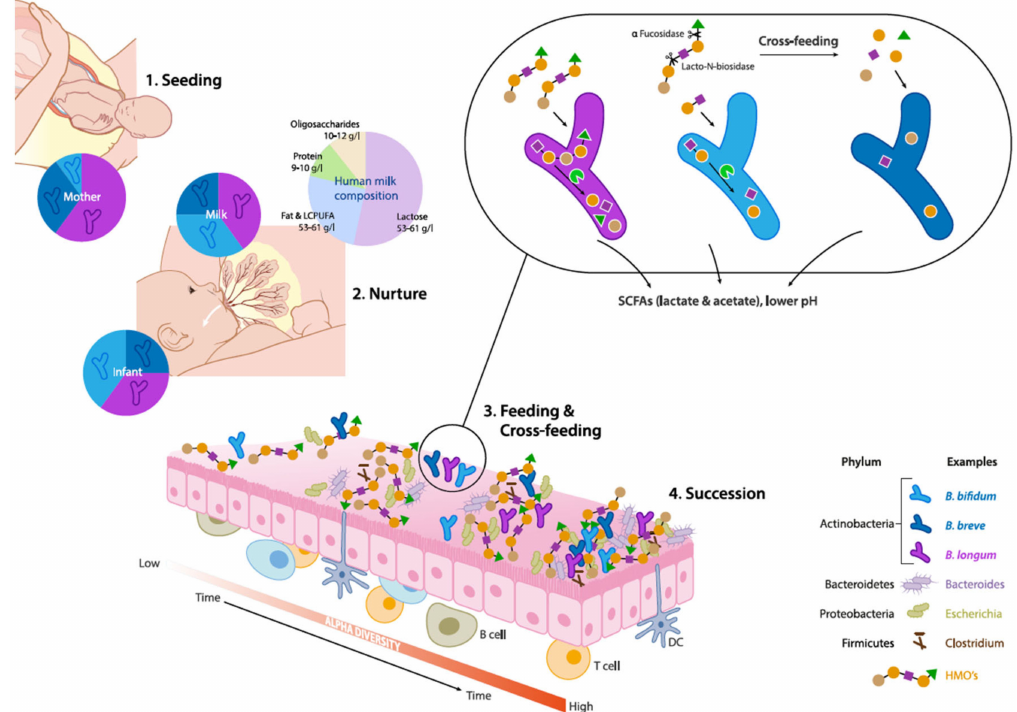
Figure 1. Schematic overview of eco-physiological factors driving maternal transmission, colonization and succession of Bifidobacterium species in the early life gut microbiota. (1) Seeding: Bifidobacteria are transmitted from mother to child during vaginal delivery. (2) Nurture: Human milk contains viable microorganisms, including Bifidobacterium species, which contribute to seeding the infant’s gut microbiota. Humanmilkoligosaccharides(HMOs)areminimallydigestedbytheinfantandmetabolized by infant-type bifidobacteria by convergent mechanisms. (3) Feeding & Cross-feeding: di ff erent Bifidobacterium species and strains have distinct HMO degrading abilities resulting in varied HMO consumption behaviors. Degradation of HMO occurs sequentially with the removal monosaccharides and requires a multitude of enzymes with various glycosidic specificities. Bifidobacterial cross-feeding permits the sharing of resources to maximize nutrient consumption from the diet and highlights the cooperative nature of bifidobacterial strains and their role as ”key stone” species in the infant gut microbiota. (4) Succession: The combined activity of Bifidobacterium species contributes to the establishment and maintenance of a strict anaerobic environment and low pH by producing metabolites such as lactate and acetate. These conditions allow the successive establishment of butyrate producing taxa such as Eubacterium and Anaerostipes spp which are characteristic for a more matured